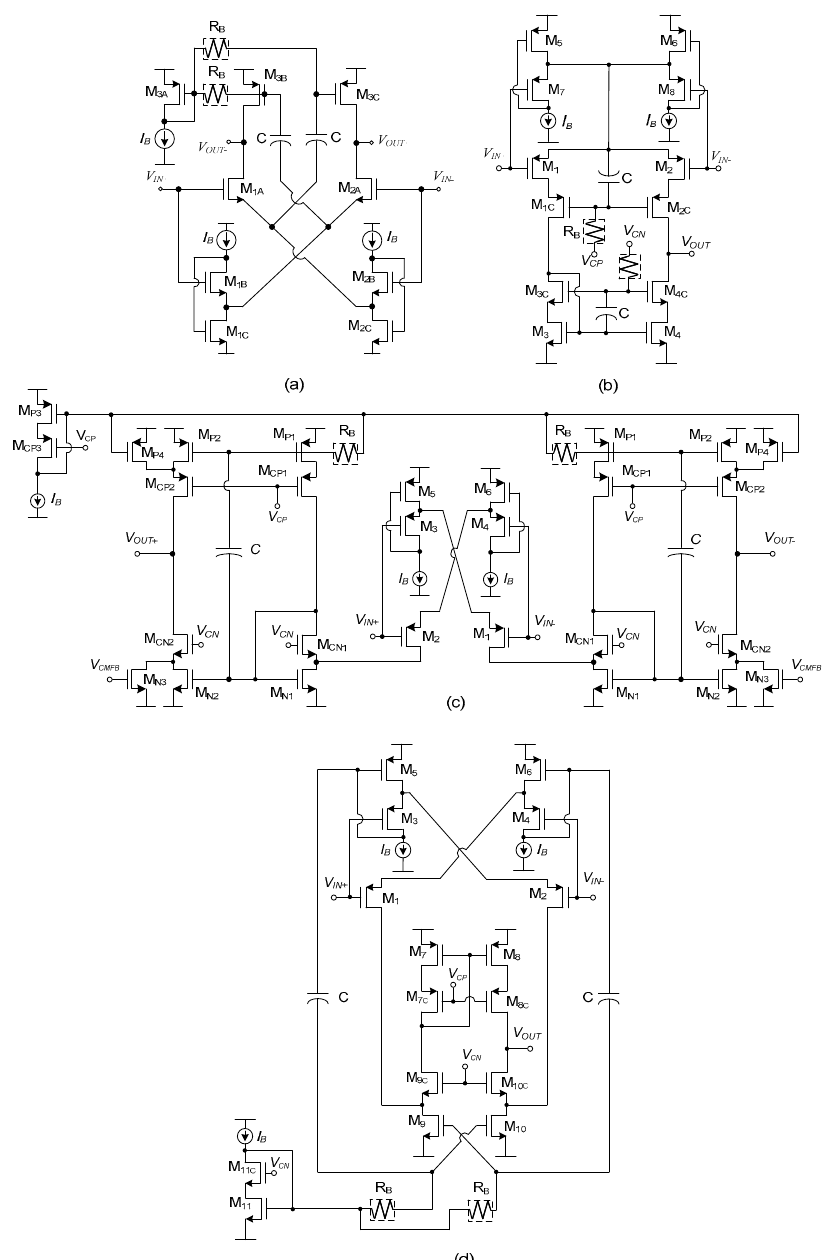
Figure 6. Single-stage class AB amplifiers. ( a ) Differential pair amplifier. ( b ) Telescopic cascode amplifier. ( c ) Current mirror amplifier. ( d ) Folded cascode amplifier.